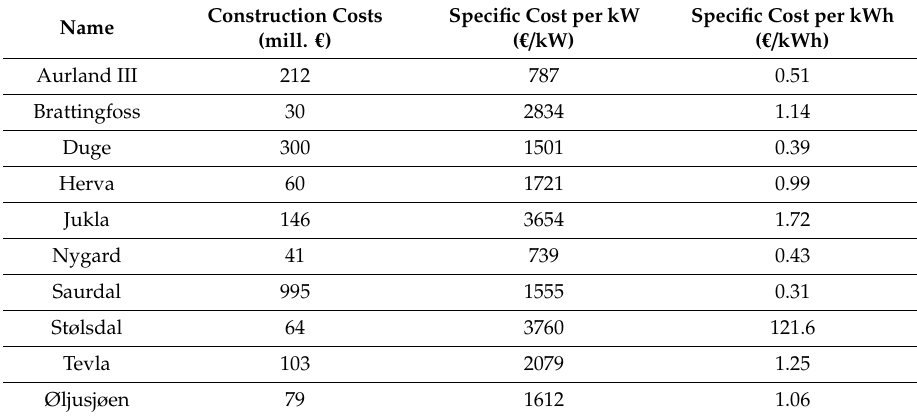
Table 3. Construction costs and specific